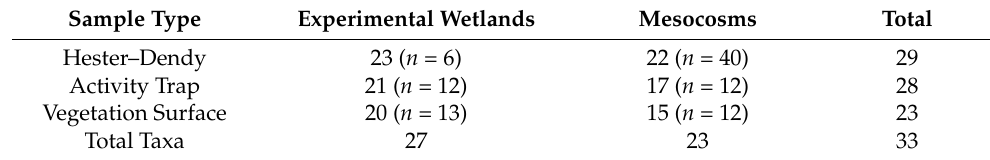
Table 9 The number of taxa found in samples by sample type and sample location.